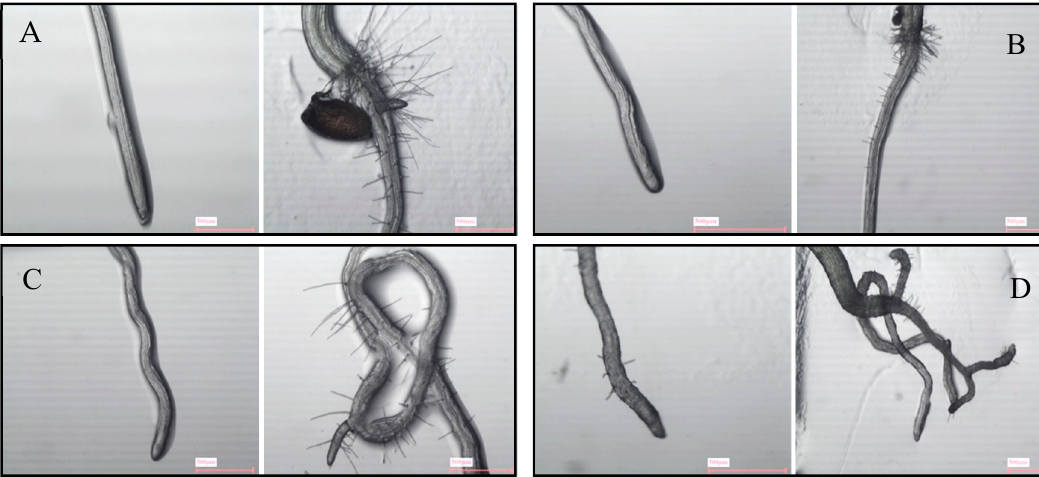
Figure 11. Apical region and transition zone of A. thaliana roots after 14 days of growth in agar with 0 ( A ), 100 ( B ), 200 ( C ), and 400 ( D ) µM carvacrol. Images were taken with a magnifier (Nikon SMZ 1500, Melville, NY, USA).